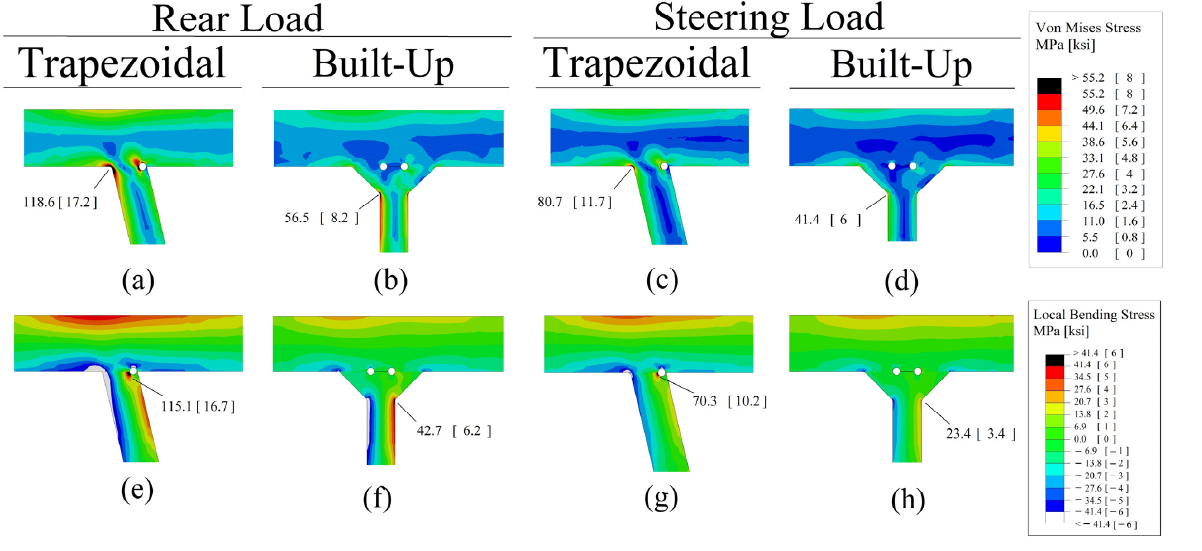
Figure 19. Von Mises and local bending stress distributions under the rear and steering wheel loads in continuum case 2.